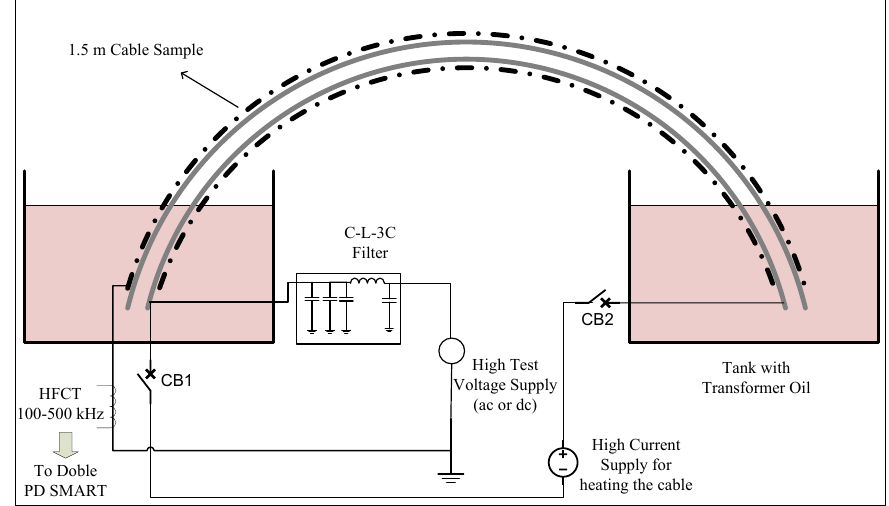
Figure 2. Schematic of the setup for PD measurements in test cable under AC and DC